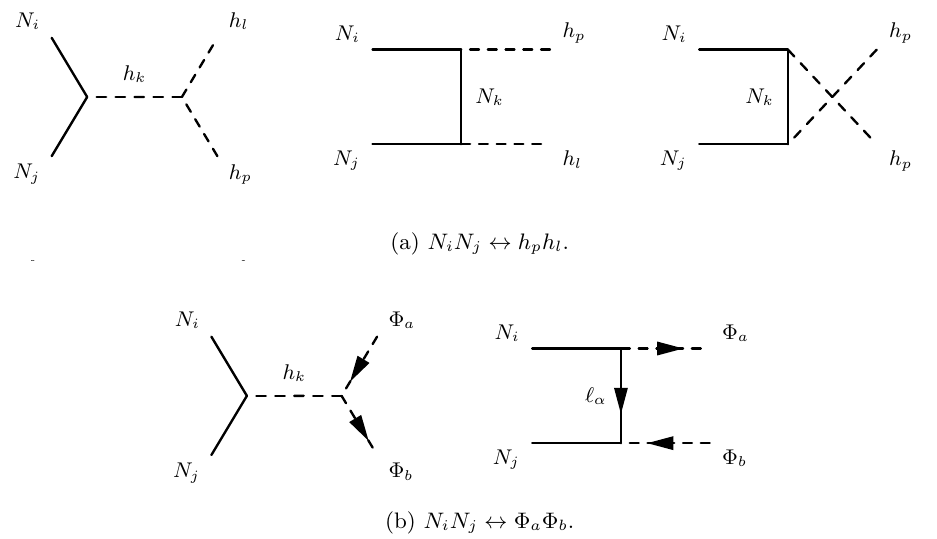
Figure 6 . Neutrino annihilation scattering contributions with ∆ N = 2